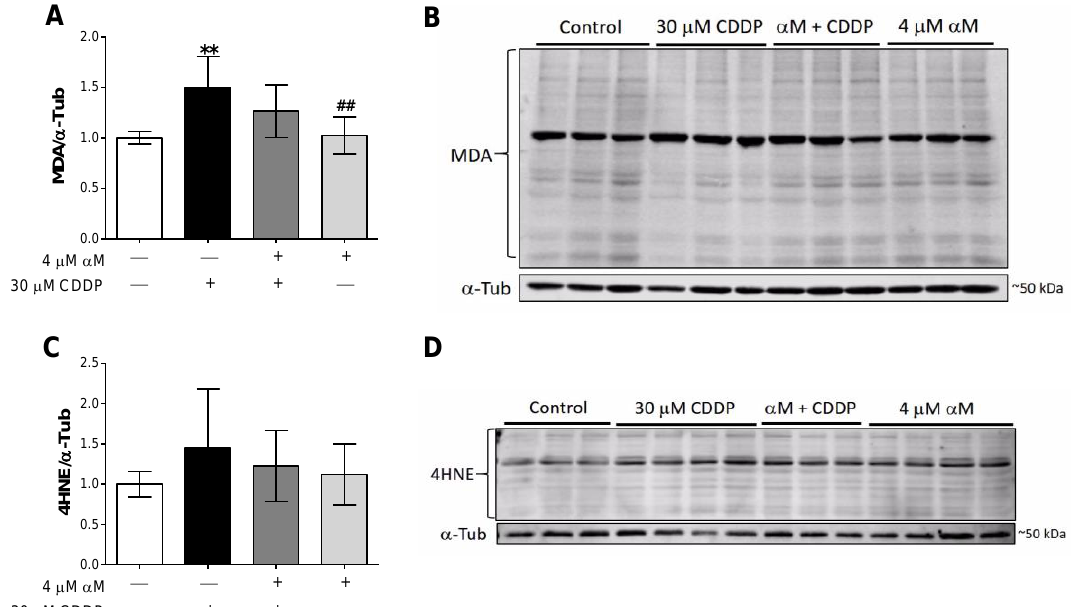
Figure 2. Changes in oxidative stress markers in LLC-PK1 cells treated with α M, CDDP or both. After 24 h of α M-, CDDP-treatment or both, the oxidative stress was evaluated by the lipoperoxidative markers ( A ) malondialdehyde (MDA) and ( C ) 4-hydroxynonenal (4HNE). ( A ) and ( C ) show the densitometry data and ( B ) and ( C ) show the representative blots. The data are presented as mean ± SD, n = 6–7. ** p < 0.01 vs. control. ## p < 0.01 vs. CDDP. α -Tub = alpha-tubulin.